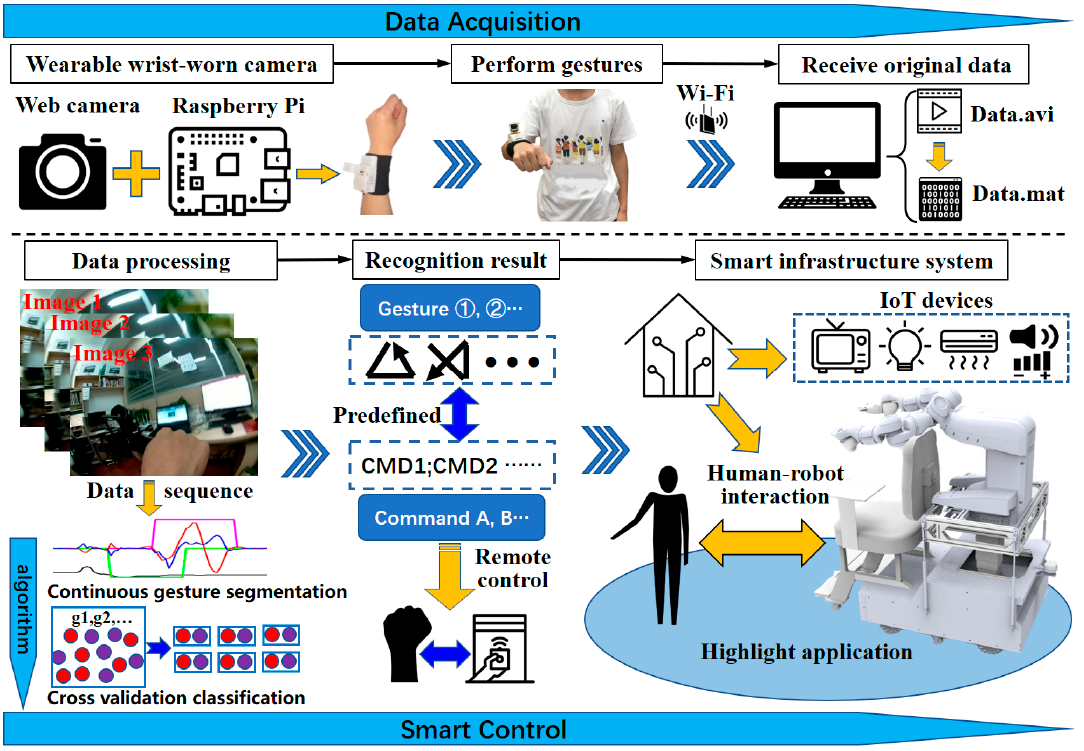
Figure 1. The flow-process diagram of the proposed hand motion trajectory (HMT) gesture recognition system based on the wearable wrist-worn camera for application in the smart infrastructure.